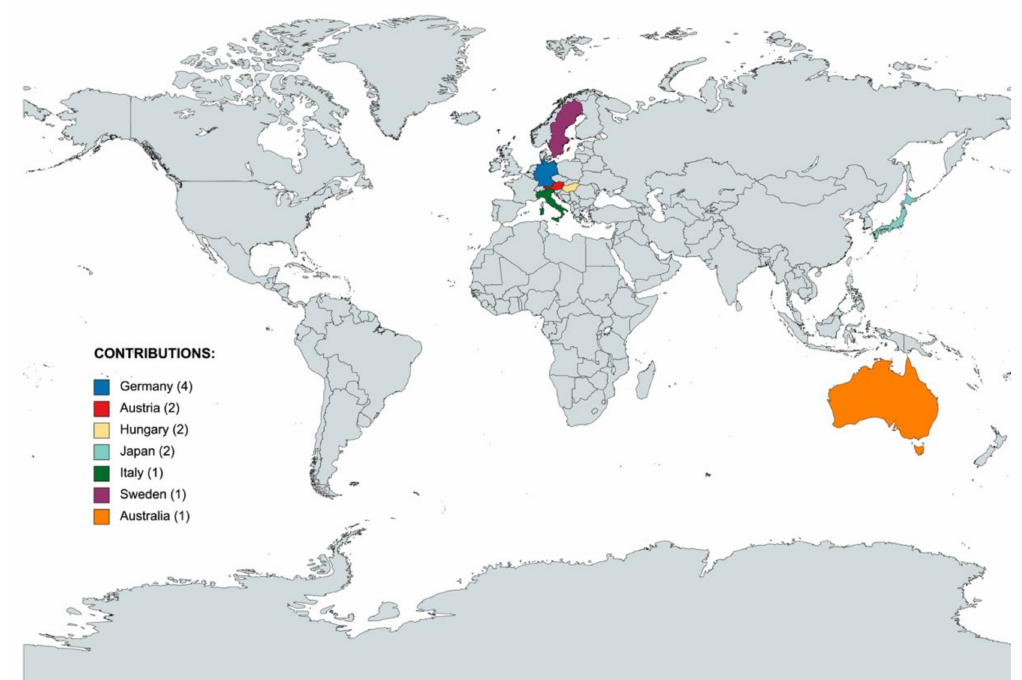
Figure 1. Affiliation of the corresponding authors who published a research or review article in the Special Issue “New Frontiers in Organ Preservation and Hepatoprotection”. This map shows an international representation with the contribution from multiple European countries, as well as from Japan and